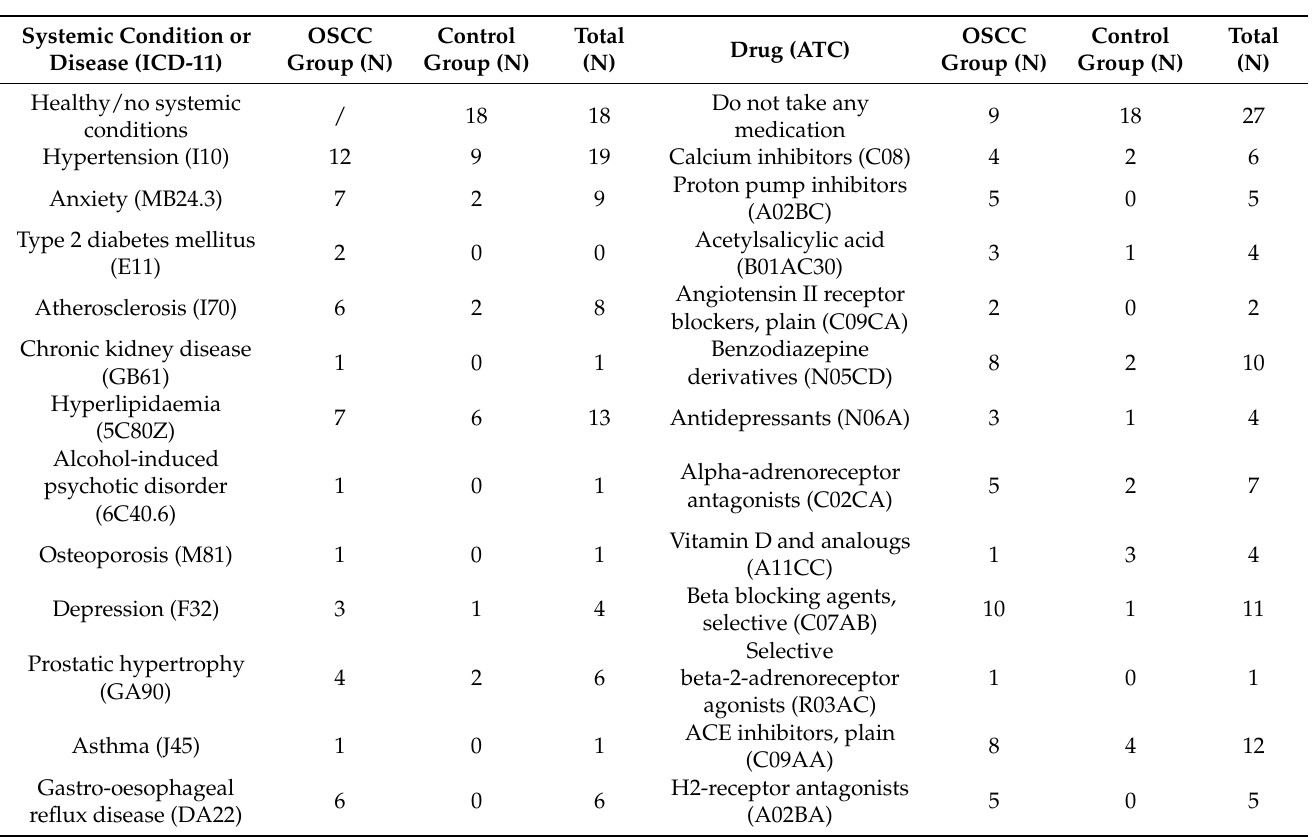
Table 2. Systemic conditions and diseases classified using the International Classification of Diseases 11th Revision (ICD-11) and drug consumption classified using the Anatomical Therapeutic Chemical (ATC) Classification System in the OSCC and control